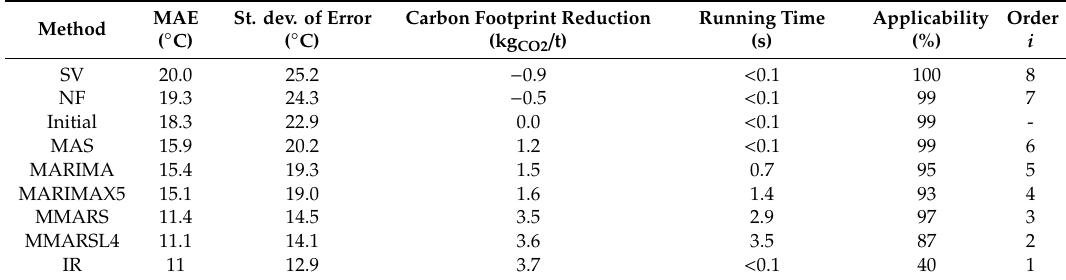
Table 5. Results for the considered